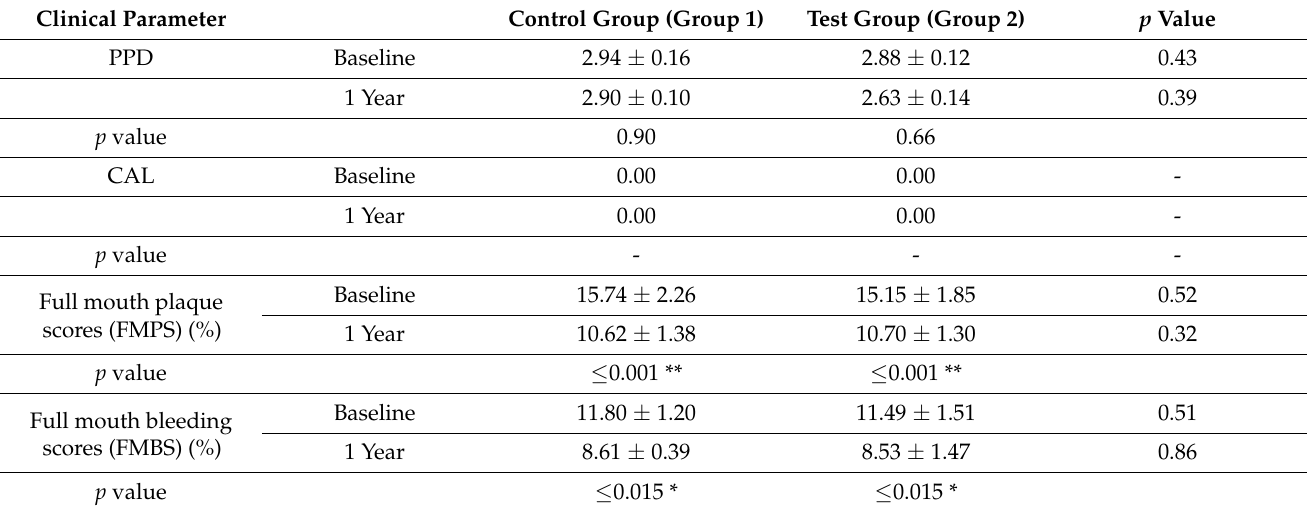
Table 1. Intergroup and intragroup comparison of clinical parameters at different timepoints.